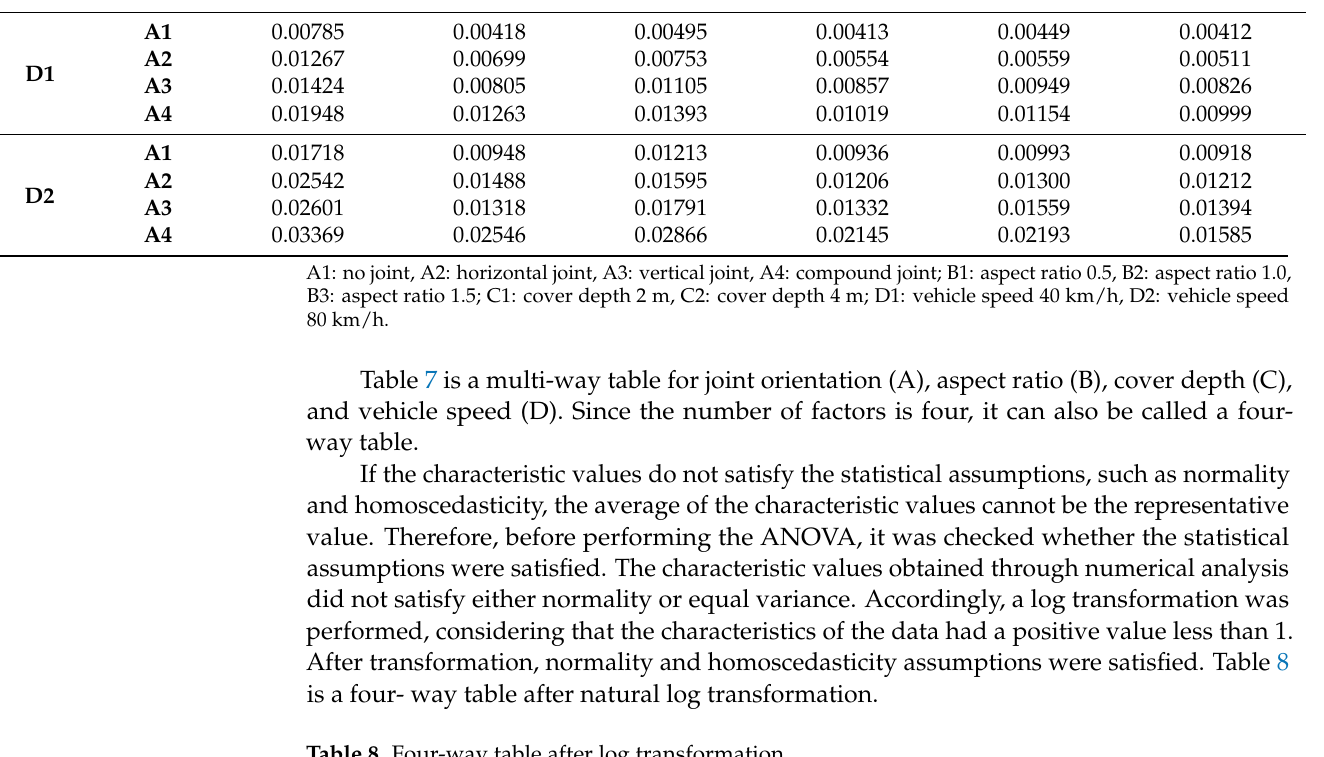
Table 8. Four-way table after log